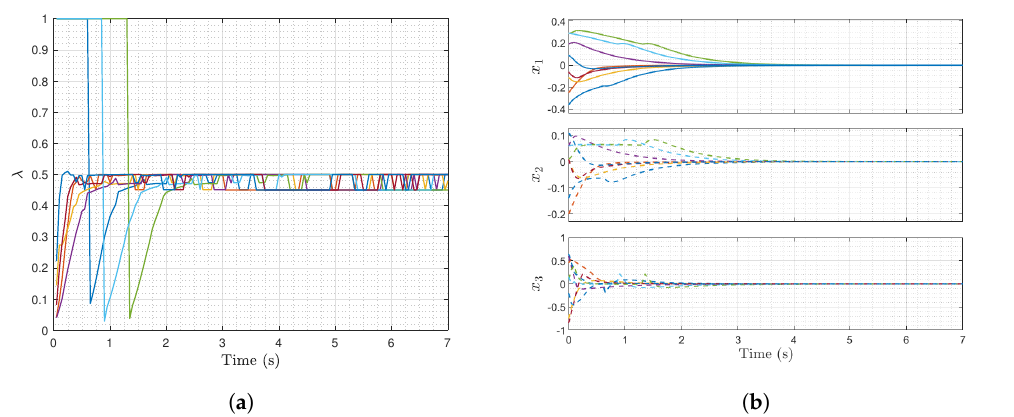
Figure 9. ( a ) Resulting λ ∈ [ 0,1 ] defining the time-varying terminal set E λ ∈ R 3 . ( b ) Trajectories from different initial states x ( 0 ) which are feasible to either E 1 or E 2